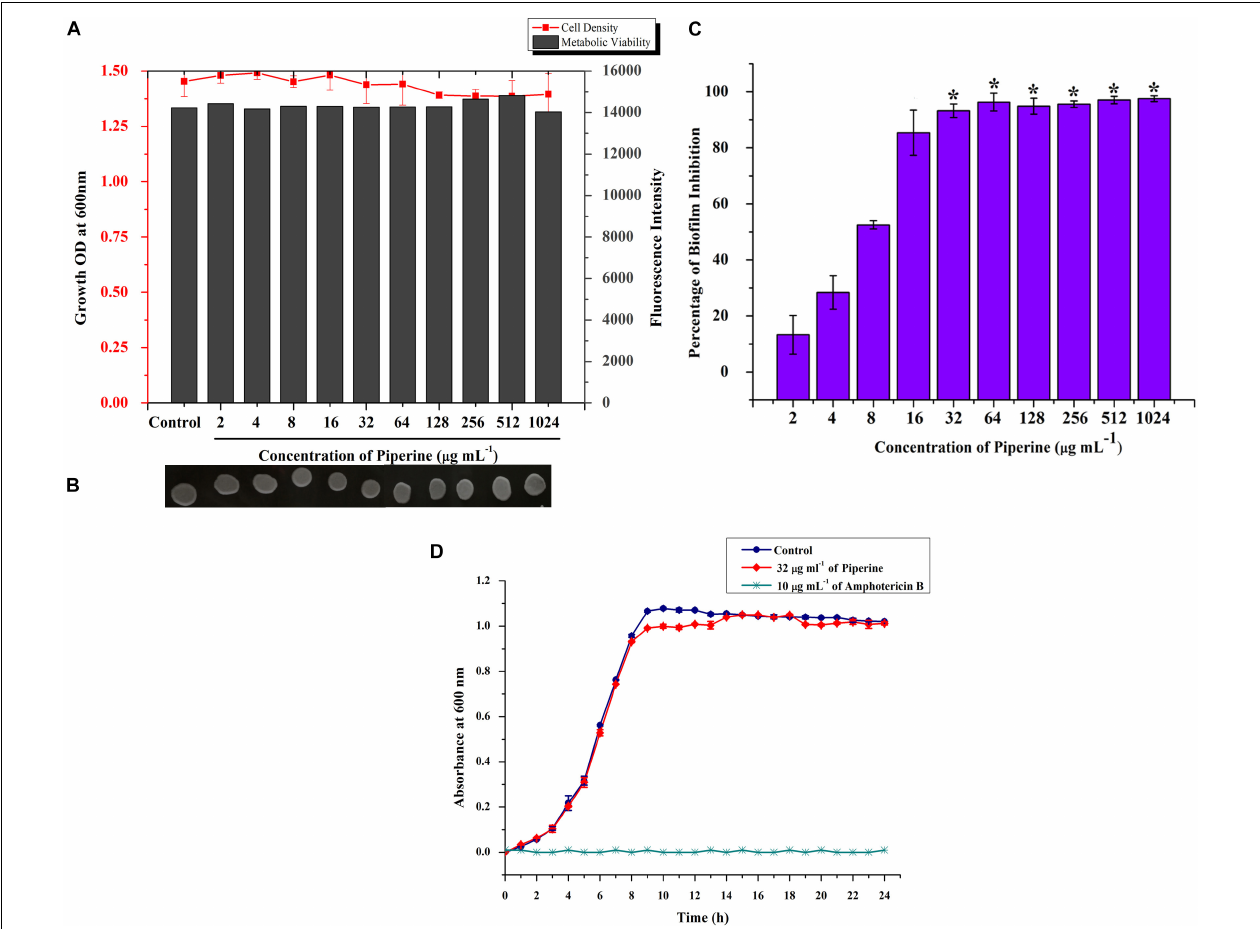
FIGURE 2 | Effect of piperine on growth, metabolic viability, and biofilm formation of C. albicans. (A) Measurement of cell density and metabolic viability of C. albicans in the absence and presence of piperine treatment. (B) Spot assay for validation of non-growth inhibitory effect of piperine. (C) Effect of piperine on biofilm formation of C. albicans. Growth and viability were not found to be significantly altered by piperine whereas biofilm formation was hindered by > 90% by the action of 32 µ g mL - 1 of piperine. Error bars represent standard deviations from the mean ( n = 3) and * p < 0.05. (D) Growth curve of C. albicans in the absence and presence of piperine at BIC. Amphotericin B was used as a positive